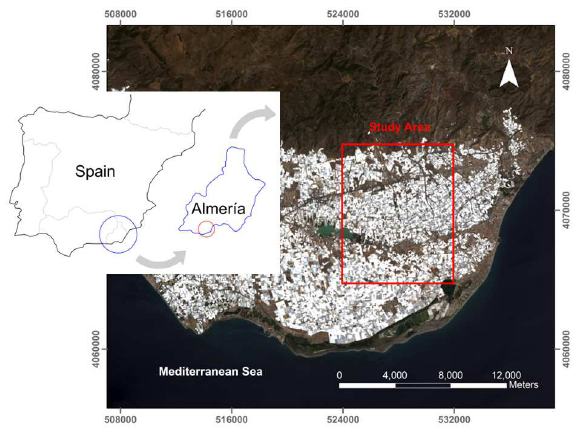
Figure 2. Location of the study area (ETRS89 UTM 30N)